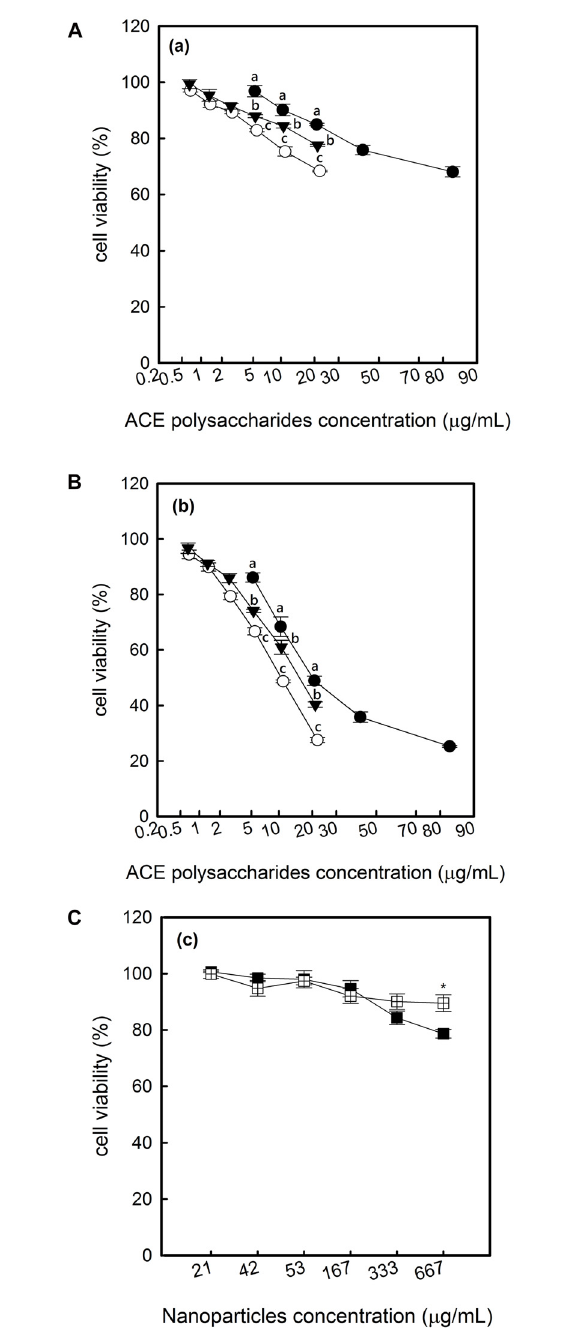
Fig 1. The cytotoxicity of ACE polysaccharides, ACE/CS and ACE/S on Hep G2 cells. Cells were incubated with samples for (a) 24 h or (b) 48 h and viability was assessed using an MTT assay. Nanoparticles without AEC polysaccharides were presented as (c) for 48 h incubation. Experiments were repeated 3 times independently to ensure reproducibility and the standard deviation of the mean are represented as error bars (n = 3). Values with different letters or asterisks were significantly different ( p < 0.05) at corresponding concentrations between different treatments ( ● ) ACE polysaccharides: A . camphorata extract, polysaccharides; ( (cid:5) ) ACE/CS: ACE polysaccharides encapsulated by chitosan-silica nanoparticles; ( ▼ ) ACE/S: ACE polysaccharides encapsulated by silica nanoparticles; ( ■ ) SNP: silica nanoparticles; ( □ ) CSNP: chitosan-silica